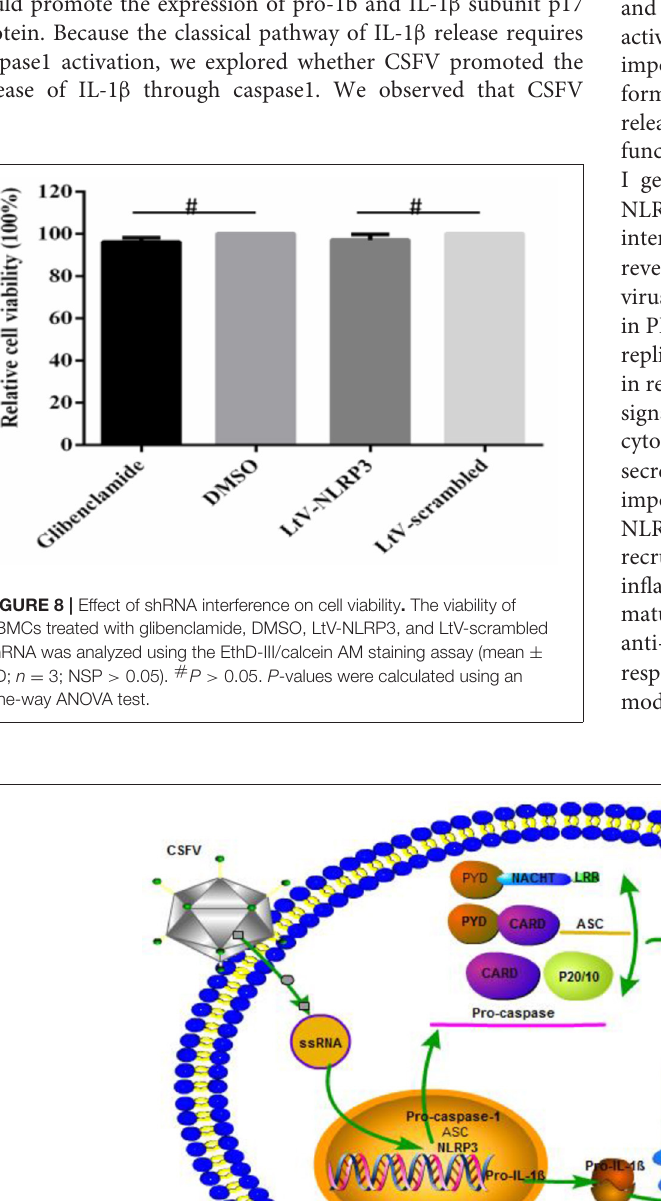
Frontiers in Cellular and Infection Microbiology |